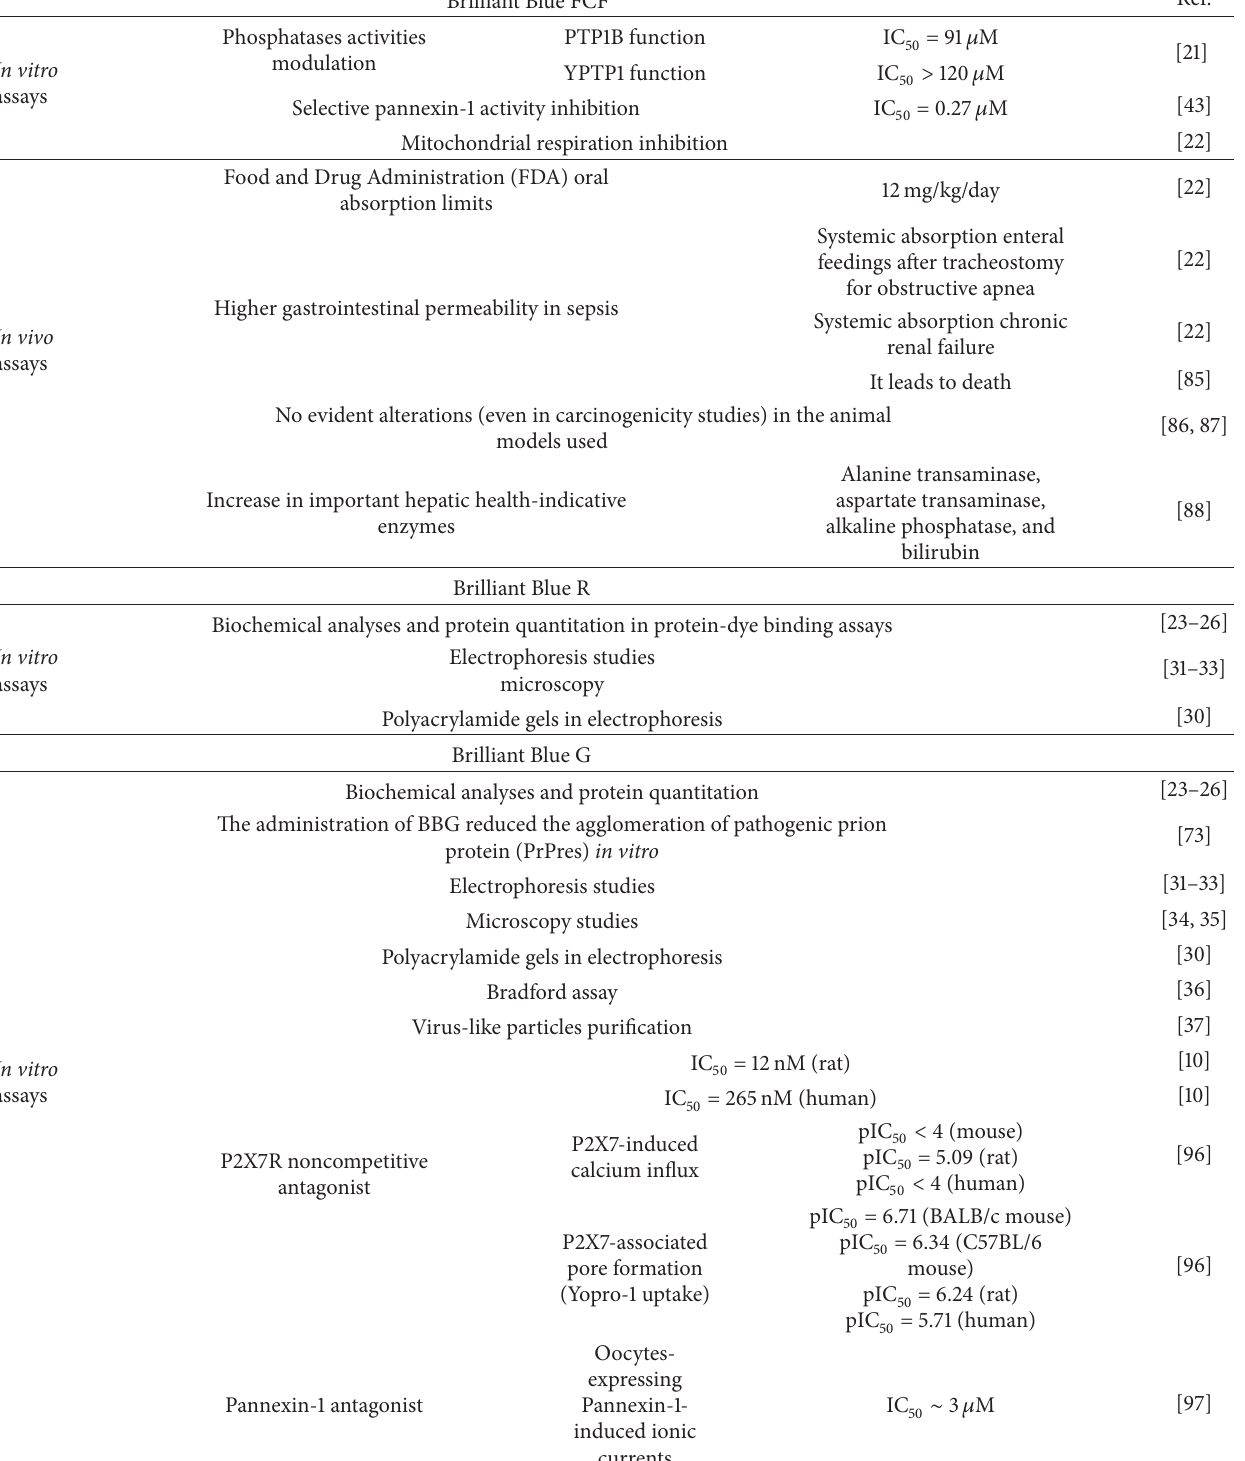
Table 1: The main studies of the Brilliant Blue dyes effects in vitro and in vivo assays. Brilliant Blue FCF